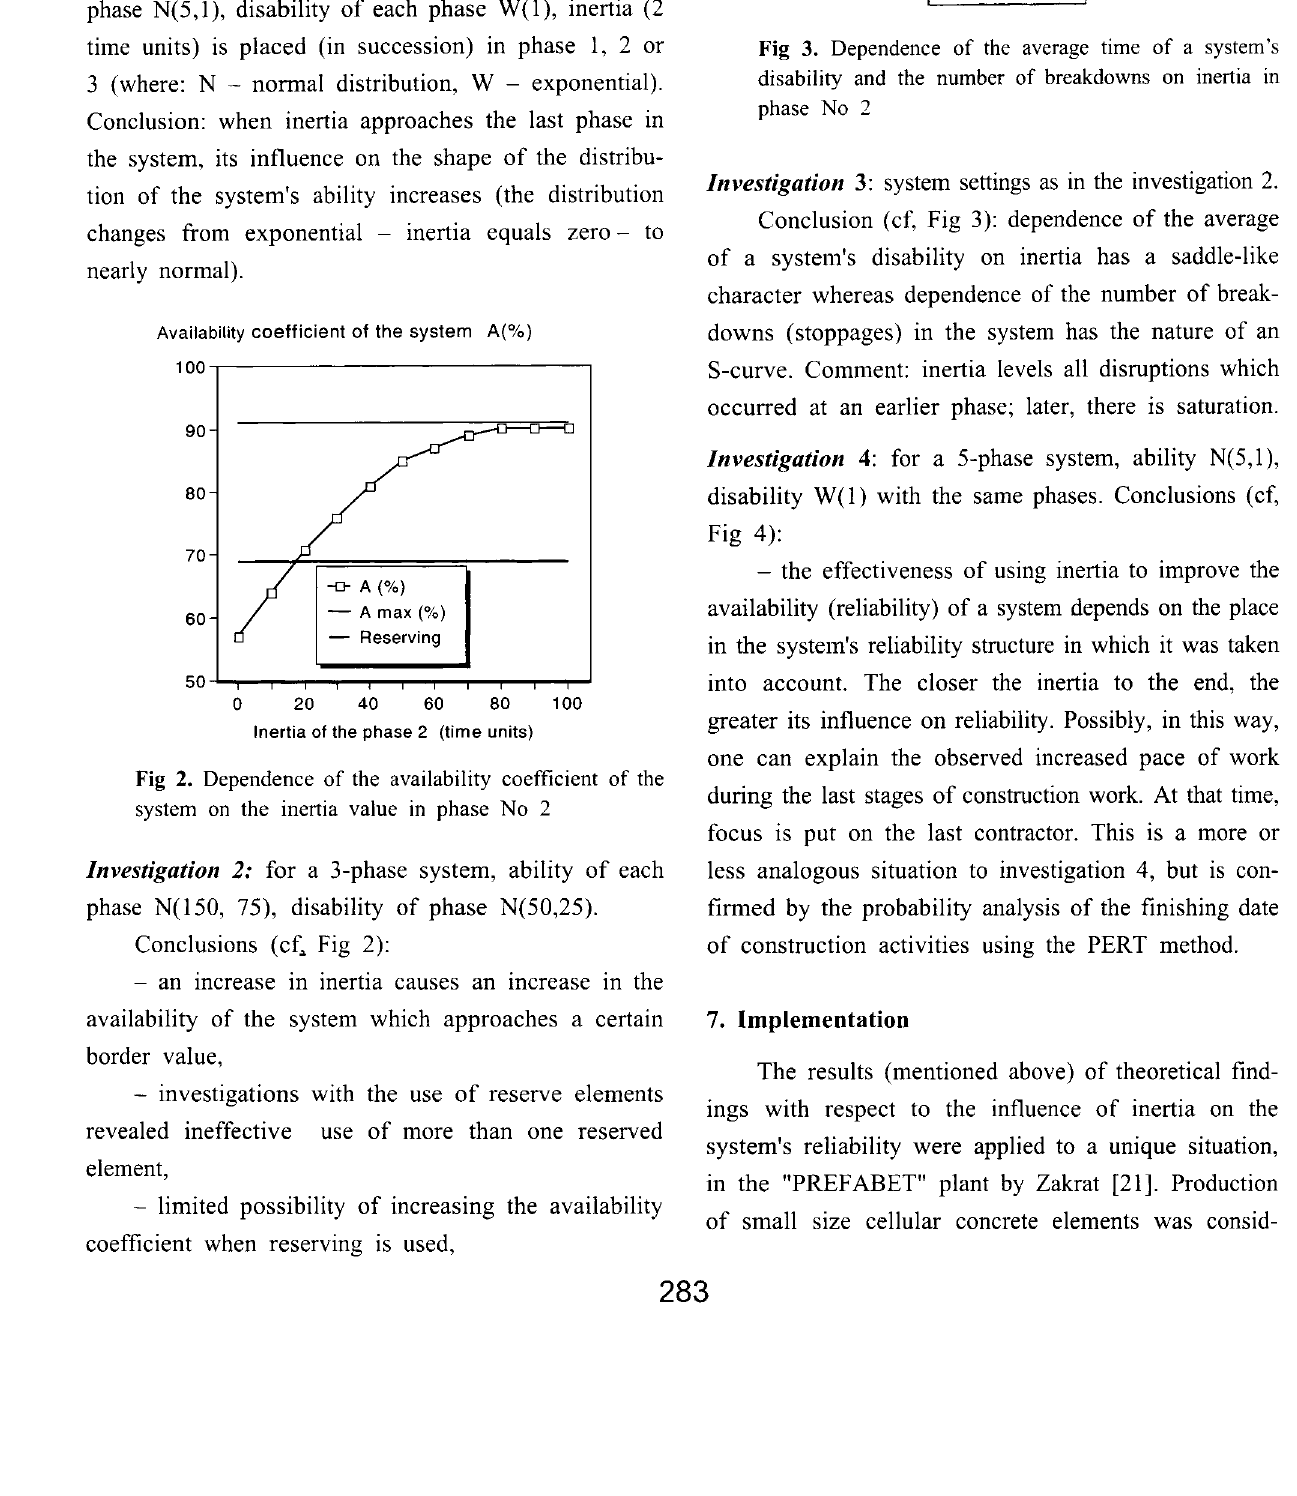
Fig 3. Dependence of the average time of a system's disability and the number of breakdowns on inertia in phase No